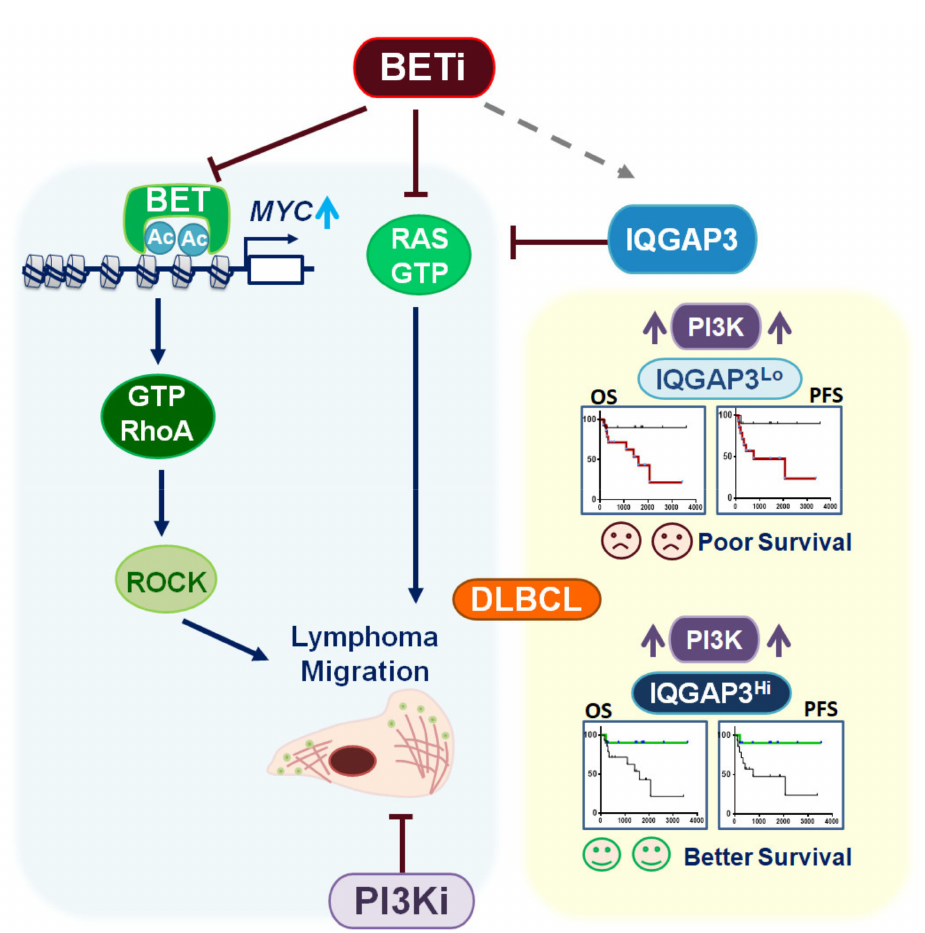
Figure 7. A schema demonstrating the molecular mechanism of BET and PI3K inhibition in DLBCL as well as the functional role and prognostic relevance of IQGAP3 in these